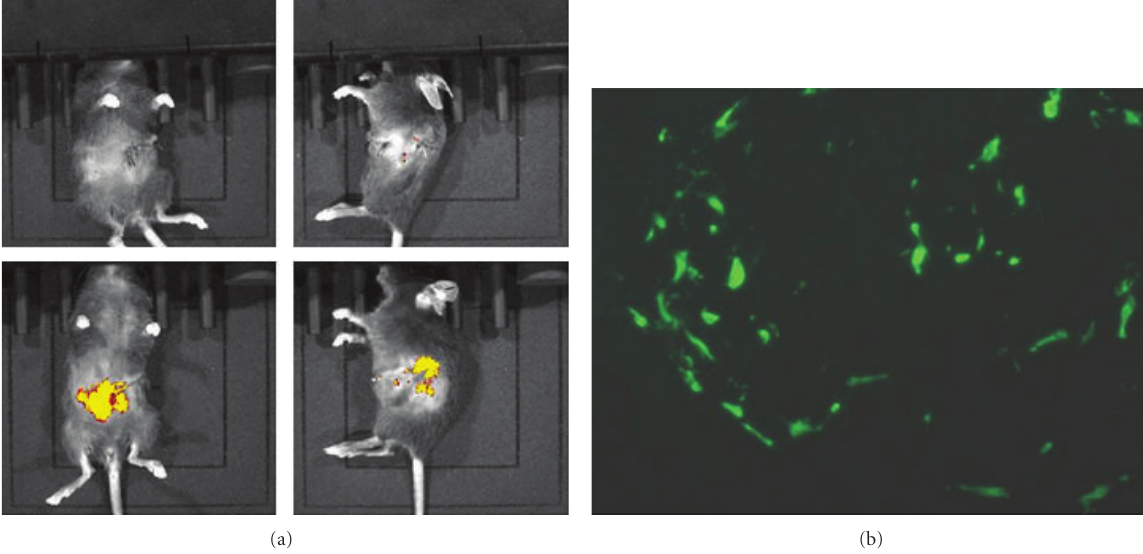
Figure 7: Migration of MSCs towards the hepatectomized liver through splenic vein. 5 × 10 5 Cxcr4-MSCs labeled with Vybrant DiD dye were administered to Abcc6 − / − ; Rag1 − / − mice via spleen 24 hours after partial hepatectomy, and the livers were examined at day 7 of transplantation for the homing of the transplanted cells. (a) Representative fluorescence images of hepatectomized mice after MSCs transplantation at Day 7 (lower panels). The images were examined from the ventral (left panels) and lateral (right panels) sides in comparison with PBS injected hepatectomized mice as negative control (upper panels). (b) Six- μ m frozen sections were examined by immunofluoresence with an anti-GFP antibody, demonstrating the presence of GFP positive cells in the liver of mice at 7 days after intrasplenic